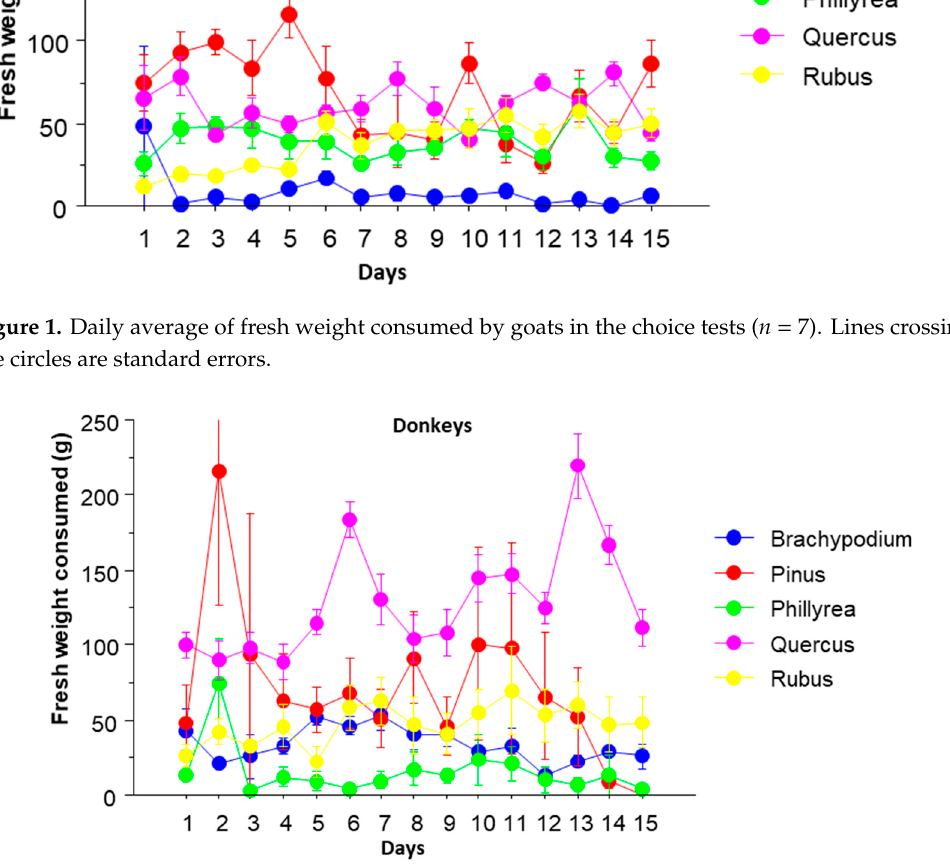
Figure 2. Daily average of fresh weight consumed by donkeys in the choice tests ( n = 7). Lines crossing the circles are standard errors.